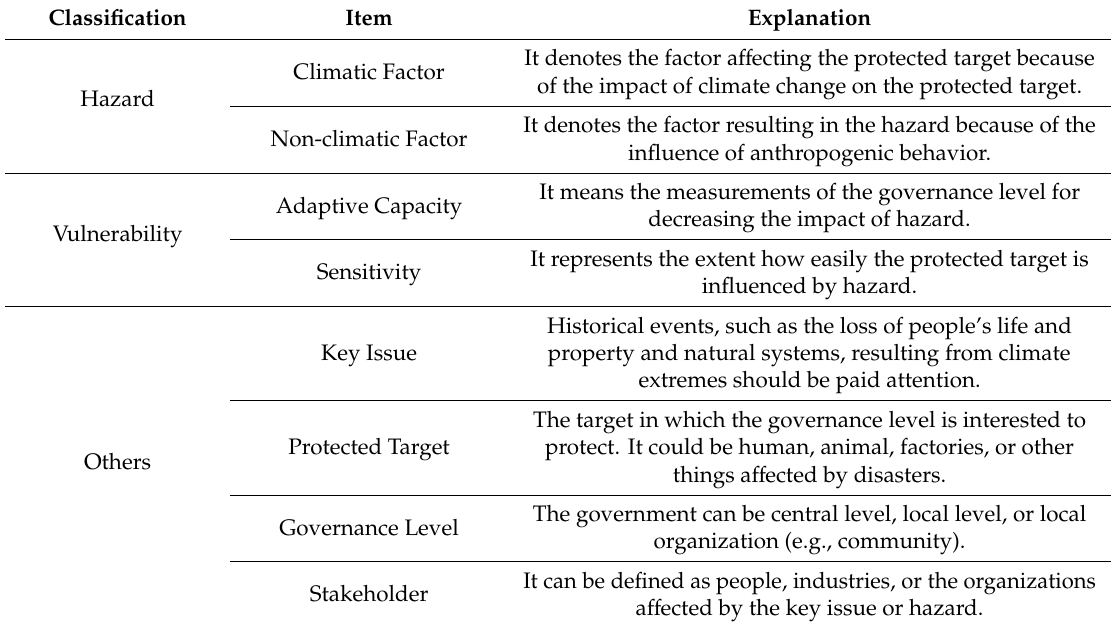
Table 5. The brief explanation of each item in the climate risk template.